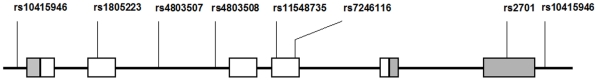
Exon-intron structure of the CEACAM6 gene and relative positions of single nucleotide polymorphisms (SNPs) investigated in the presented study.This figure represents the genomic structure of the CEACAM6 gene consisting of 6 exons and indicates the positions of the CEACAM6 SNPs studied. The SNPs rs4803507 and rs4803508 are localized in intron 2, rs2701 is localized in exon 6 encoding the 3′-untranslated region, while the SNPs rs10415946 and rs10416839 are within the 5′- and the 3′-flanking region, respectively. The coding variant rs1805223 = p.Pro42Pro is located in exon 2, while rs11548735 = p.Gly239Val and rs7246116 = pHis260His are located in exon 4. The grey part of exons 1 represents the 5′ untranslated region, the grey part of exons 5 and exon 6 represent the 3′ untranslated region.